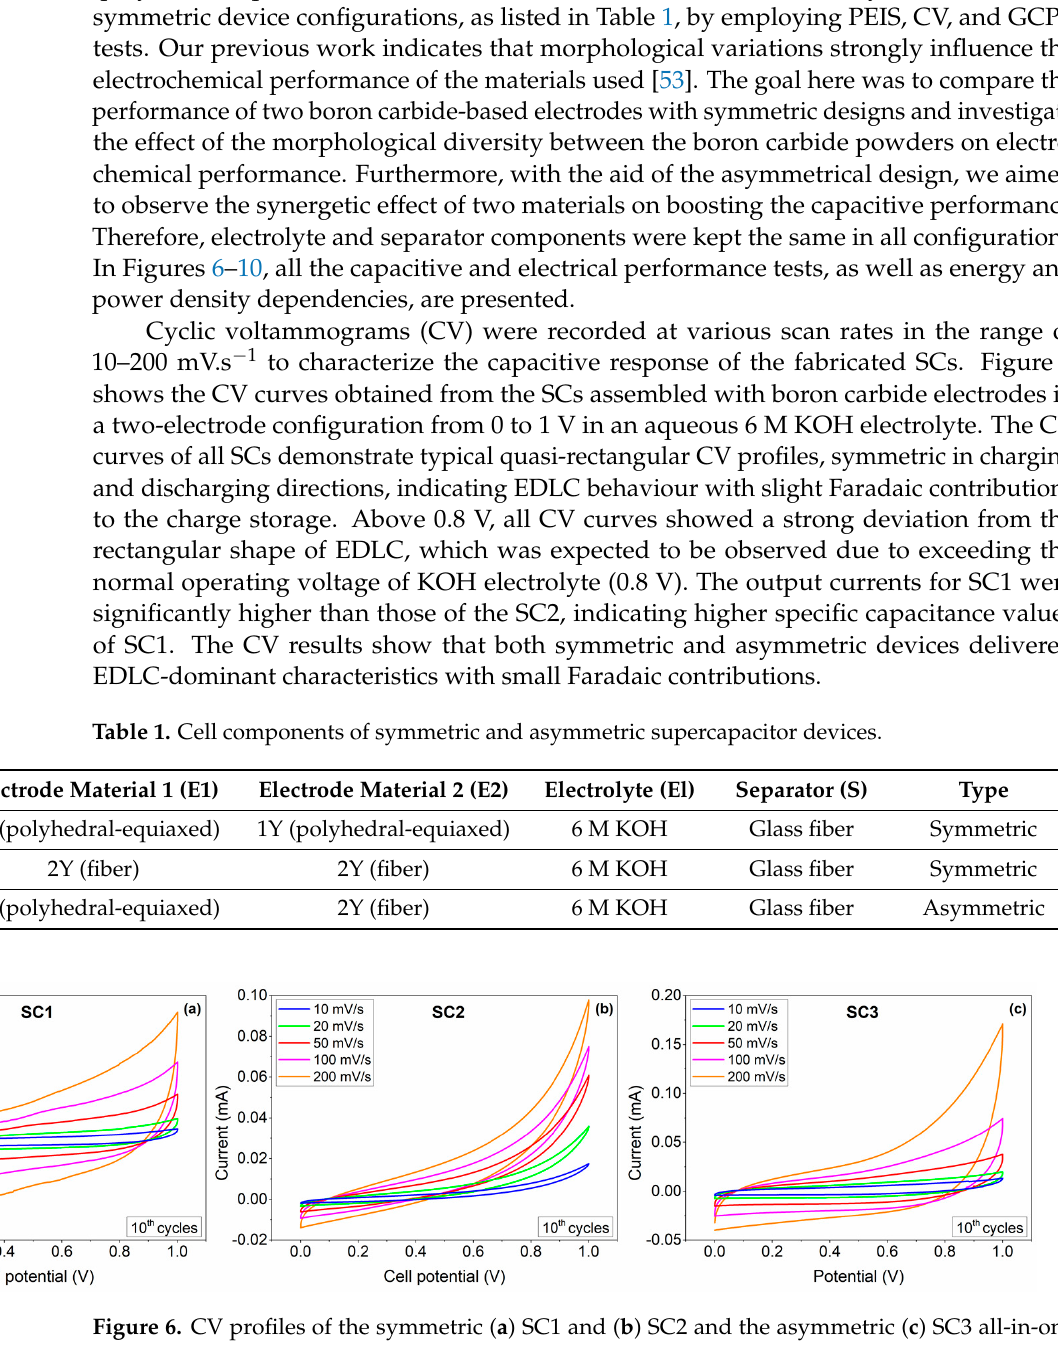
Table 1. Cell components of symmetric and asymmetric supercapacitor devices.